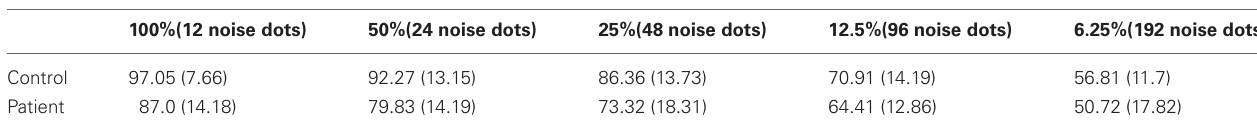
Table 2 | Performance accuracy in p-BM task: group mean ( SD ).